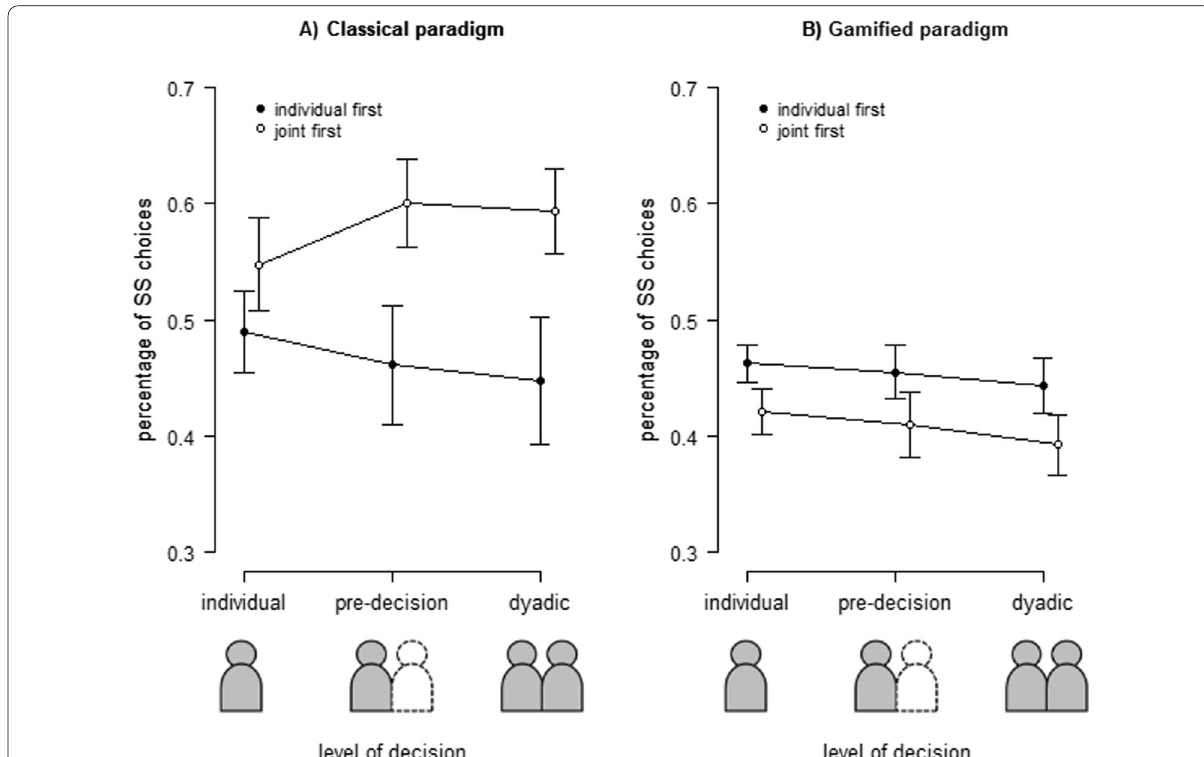
Fig. 5 Results of exploratory analyses of Experiment 2. Relative frequency of SS choices in different levels of decision-making (individual decision, pre-decision, dyadic decision). Error bars indicate standard errors of the mean. ( A ) Results of the classical intertemporal choice paradigm separated by the order of conditions. ( B ) Results of the gamified intertemporal choice paradigm separated by the order of